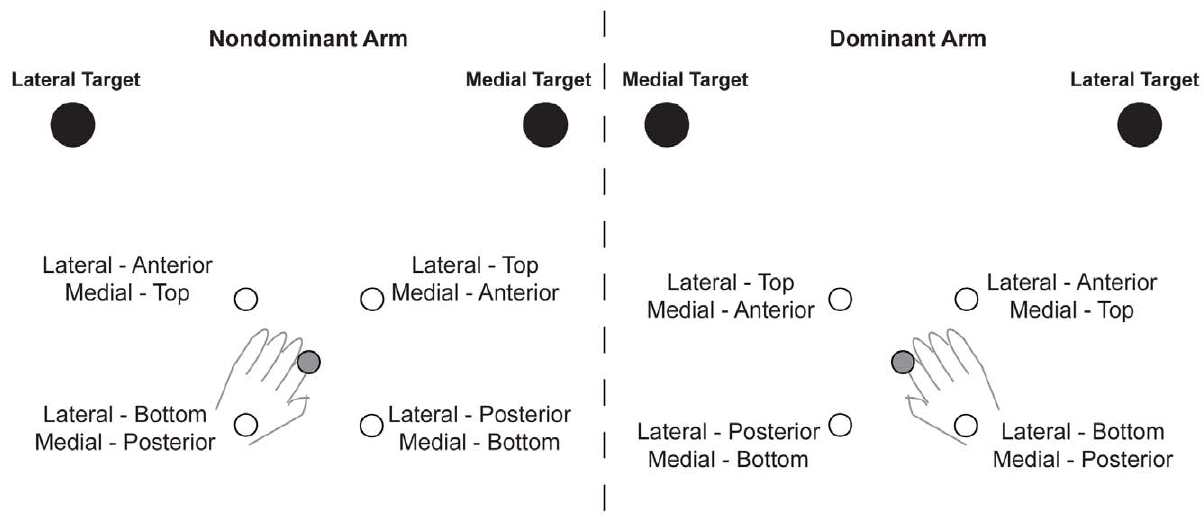
Figure 1. Shifts in start location. Note that shifted start positions were ‘‘shared’’ between the targets. For example, the anterior start position for the lateral movement served as the top start position for the medial movement. The baseline start position was the same for the lateral and medial movement directions.